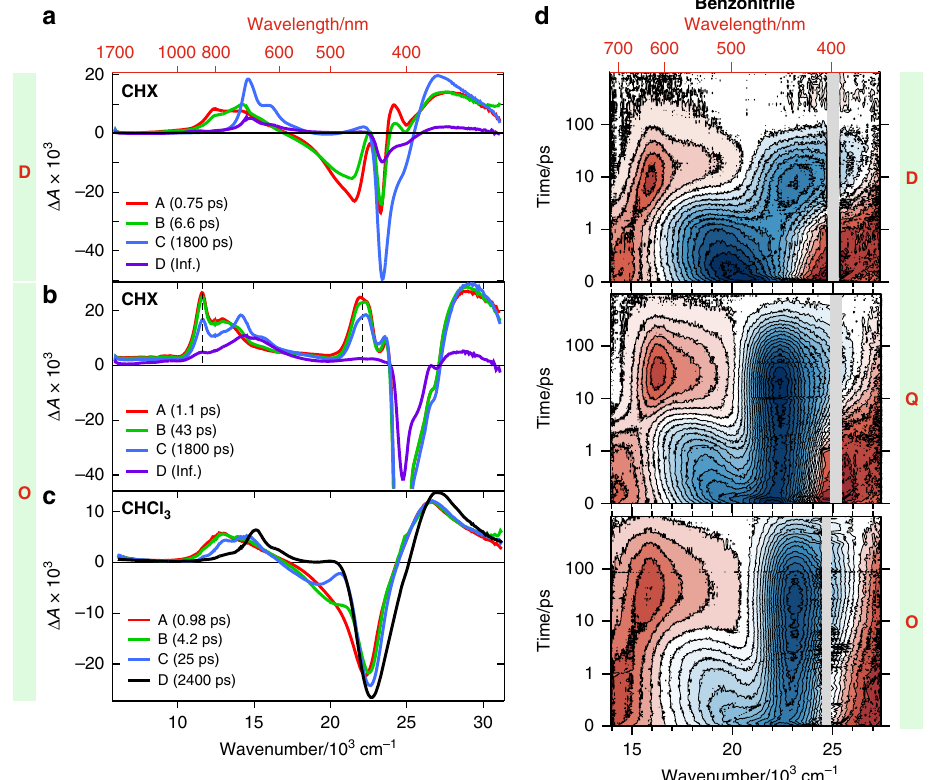
Fig. 5 UV – Vis-NIR transient absorption spectroscopy of the multipolar compounds. a – c Evolution-associated difference spectra obtained from a global analysis of the UV – Vis-NIR transient absorption data of D and O in non-polar ( a , b ) and of O in polar ( c ) media for a consecutive A → B → C → D → scheme. In non-polar media, the evolution-associated difference spectra (EADS) D is assigned to the triplet state, whereas in polar solvents it is attributed to the relaxed allene product. d Transient absorption contour plots of D , Q , O in the highly polar benzonitrile. Positive excited-state absorption bands are in red, whereas ground-state bleach and stimulated emission are in